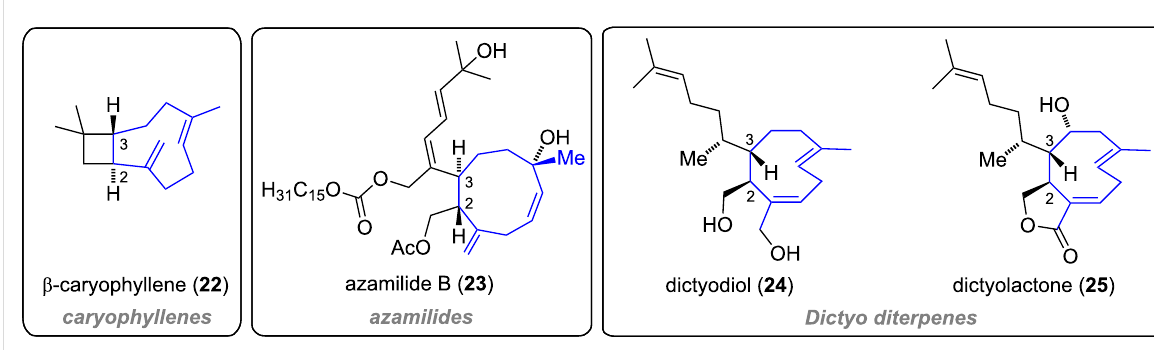
Figure 3: Representative members of the caryophyllenes, azamilides and Dictyota diterpenes.